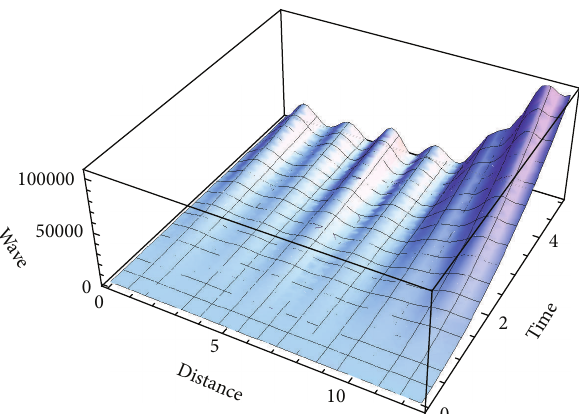
Figure 1: Solution for alpha equals 0.5 and 𝑦 = 0 .